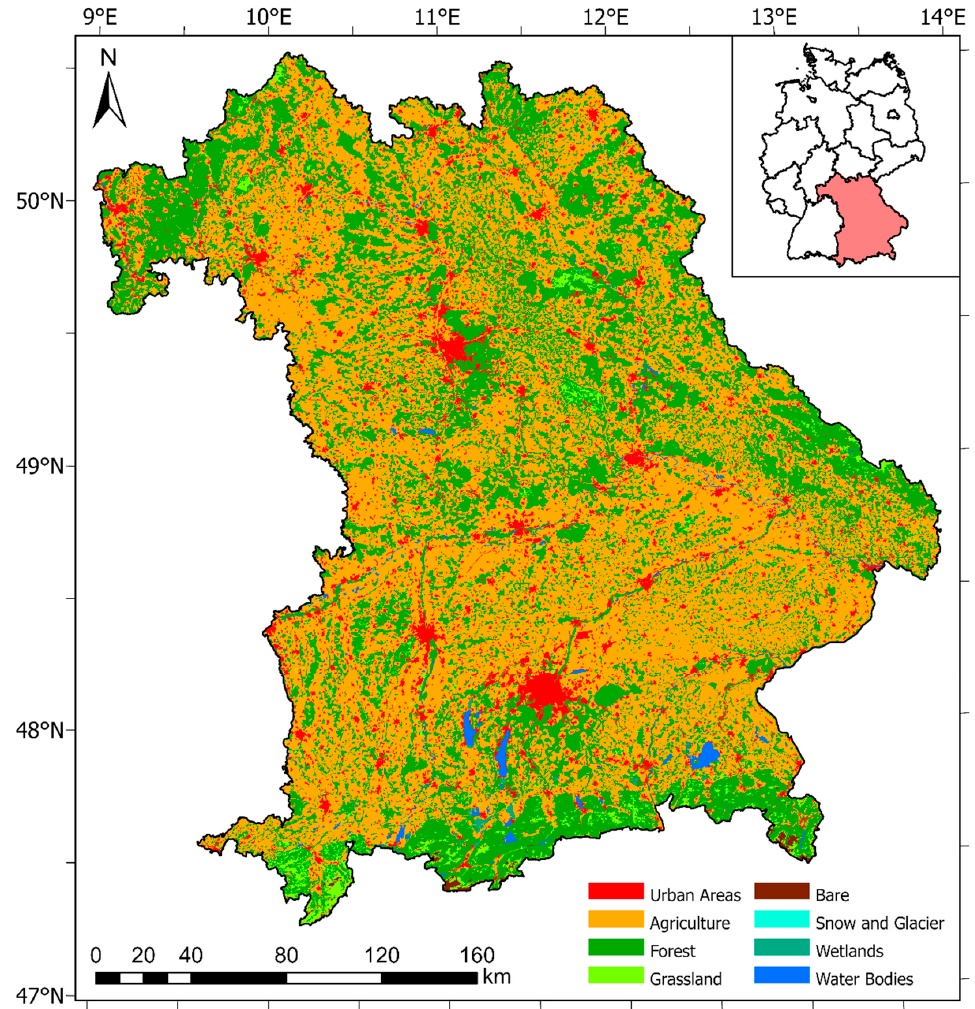
Figure 2. Land cover in Bavaria based on CLC 2018 (simplified according to Table S1). Agricultural land (orange) dominates mainly in the northwest and southeast of Bavaria, while forested land (dark green) mainly dominates in the northeast and south. All further results and representations refer to this area, whereby a further longitude and latitude indication was omitted.